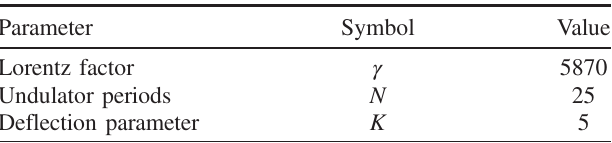
TABLE I. Electron and undulator parameters for Fig. 1. Parameter Symbol Value Lorentz factor